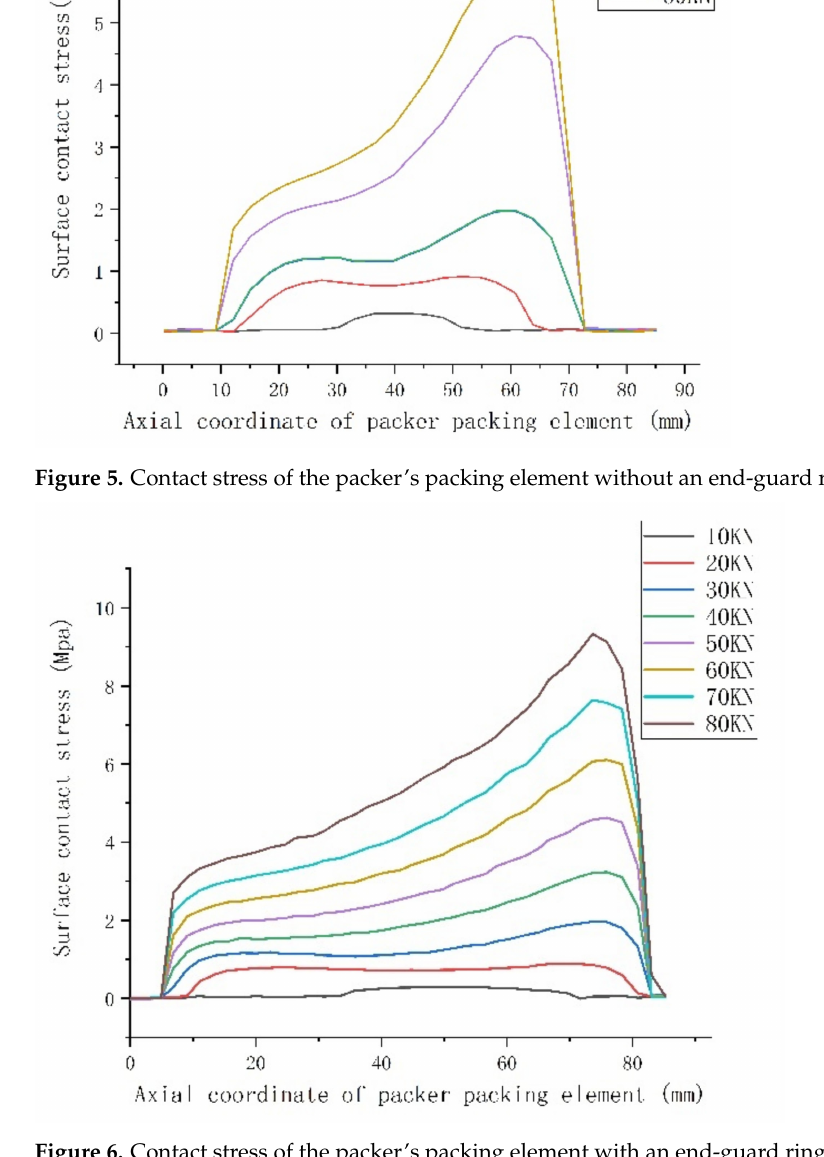
Figure 6. Contact stress of the packer’s packing element with an end-guard